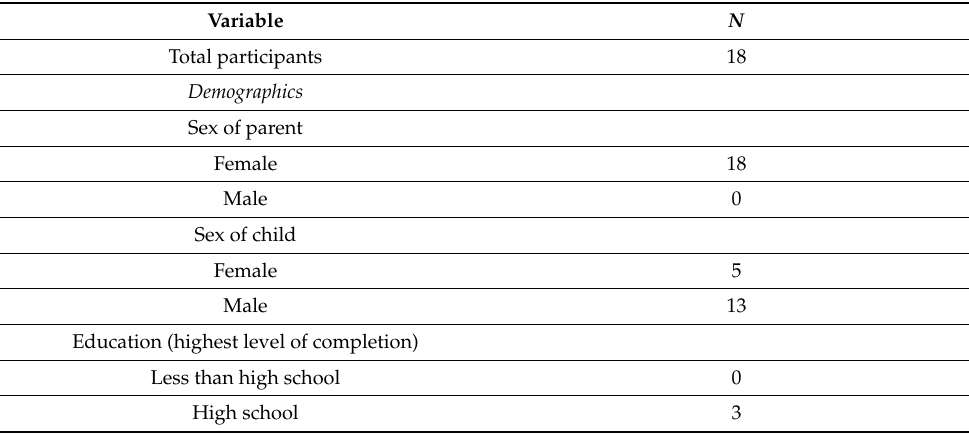
Table 1. Participant